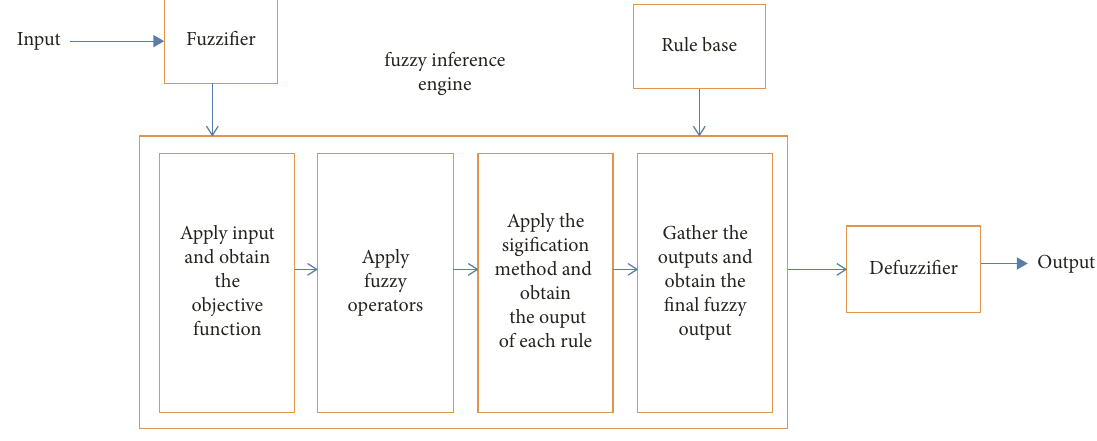
Figure 1: Steps of the fuzzy inference